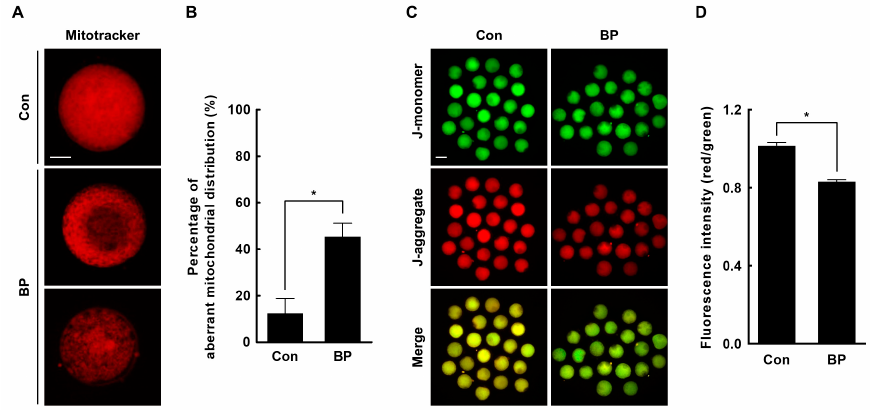
Figure 4. Effects of butylparaben (BP) exposure during in vitro maturation (IVM) on mitochondrial distribution and function. ( A ) Fluorescence images of oocytes stained with MitoTracker Deep Red in the BP-treated and control groups. Bar = 50 um. ( B ) Percentage of oocytes with aberrant mitochondrial distribution in the BP-treated and control groups (Con; n = 53, BP; n = 53). ( C ) Fluorescence images of oocytes stained with JC-1 in the BP-treated and control groups. Bar = 100 um. ( D ) Quantification of the fluorescence intensity (red/green) in the indicated groups (Con; n = 62, BP; n = 62). The data are from three independent experiments and the values represent the mean ± SEM. * p < 0.05.